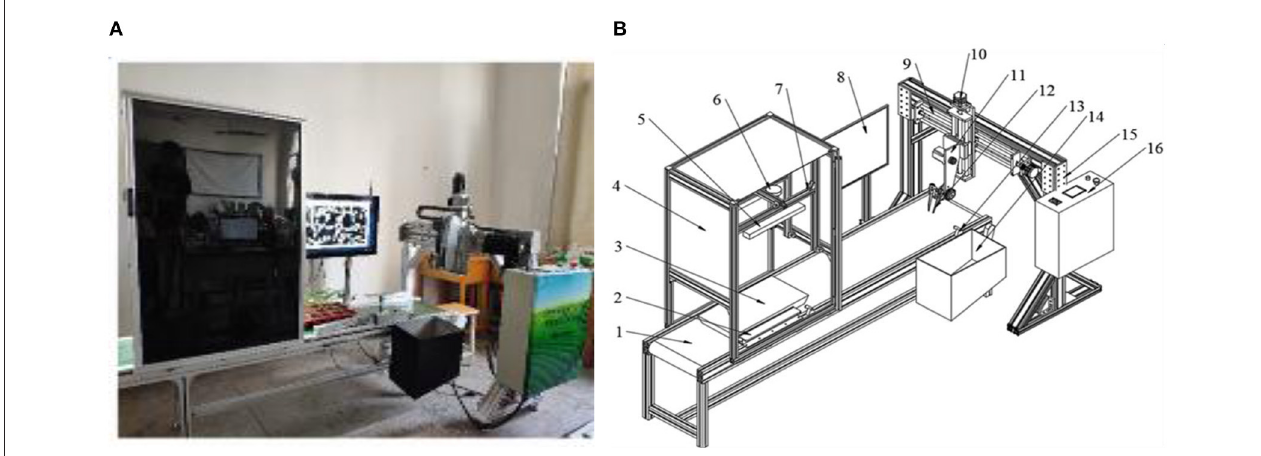
FIGURE 1 | System modeling. (A) Physical prototype; (B) System structure diagram: 1, conveyor belt; 2, limit device; 3, tray with seedlings; 4, lightbox; 5, compensatory light; 6, charge-coupled device (CCD) camera; 7, frame; 8, personal computer; 9, cross slide; 10, stepping motor; 11, manipulator mounting plate; 12, end-effector; 13, diffuse reflection laser sensor; 14, recovery box; 15, gantry; 16, programmable logic controller (PLC).